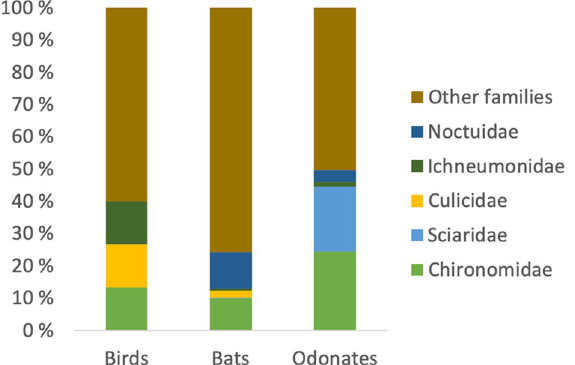
Figure 2. Prey use at the family level. Shown are the frequencies of the five most common families (DIPTERA: Chironomidae, Sciaridae, Culicidae; HYMENOPTERA: Ichneumonidae; and LEPIDOPTERA: Noctuidae) and of other families combined in the diet of each predator group. Chironomids are the biggest prey group for all of the insectivorous